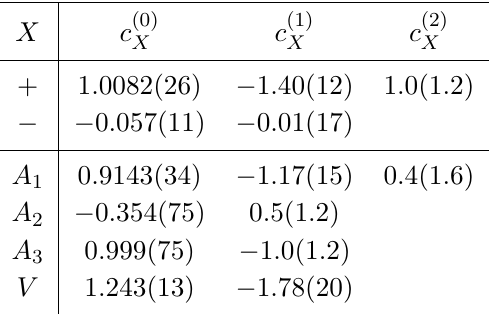
Table 4 . Numerical coefficients c ( i ) to parametrize the form factors of B → D ( X = + and X − ) and B → D ∗ ( A 1 , A 2 , A 3 and V ) decays. A polynomial expansion of the form h X ( w )